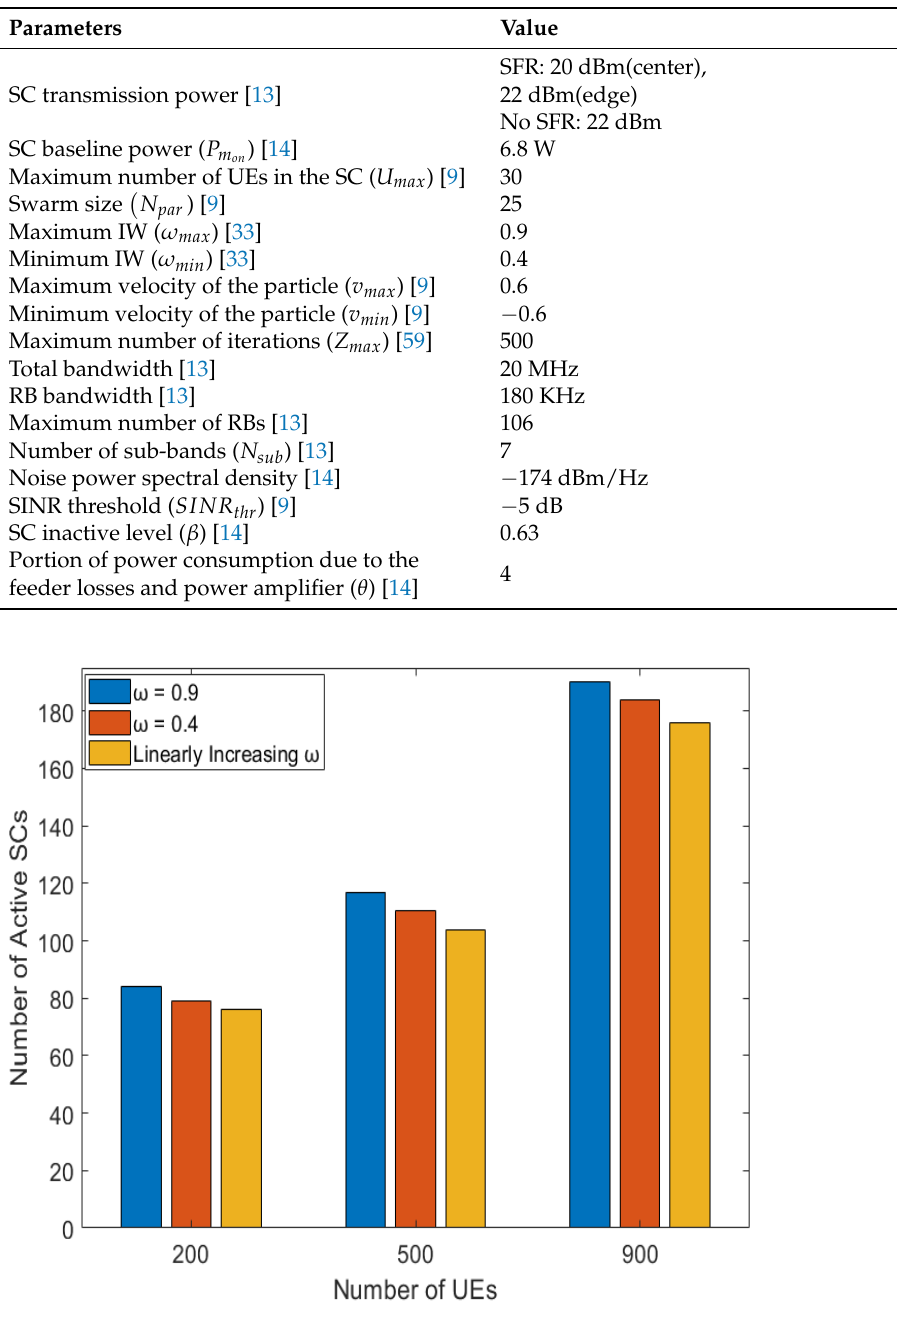
Figure 5. Number of active SCs for various numbers of UEs for different values of